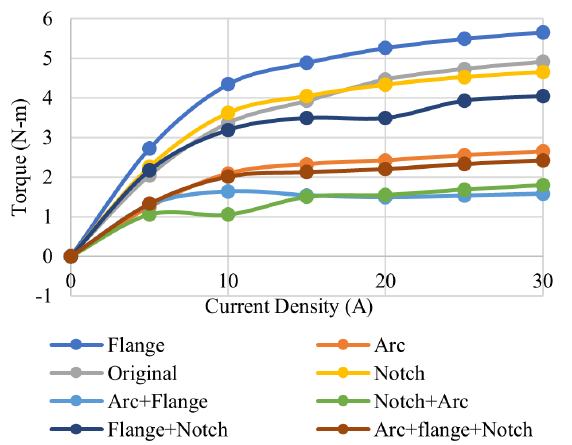
Figure 32. Average torque vs current density of different